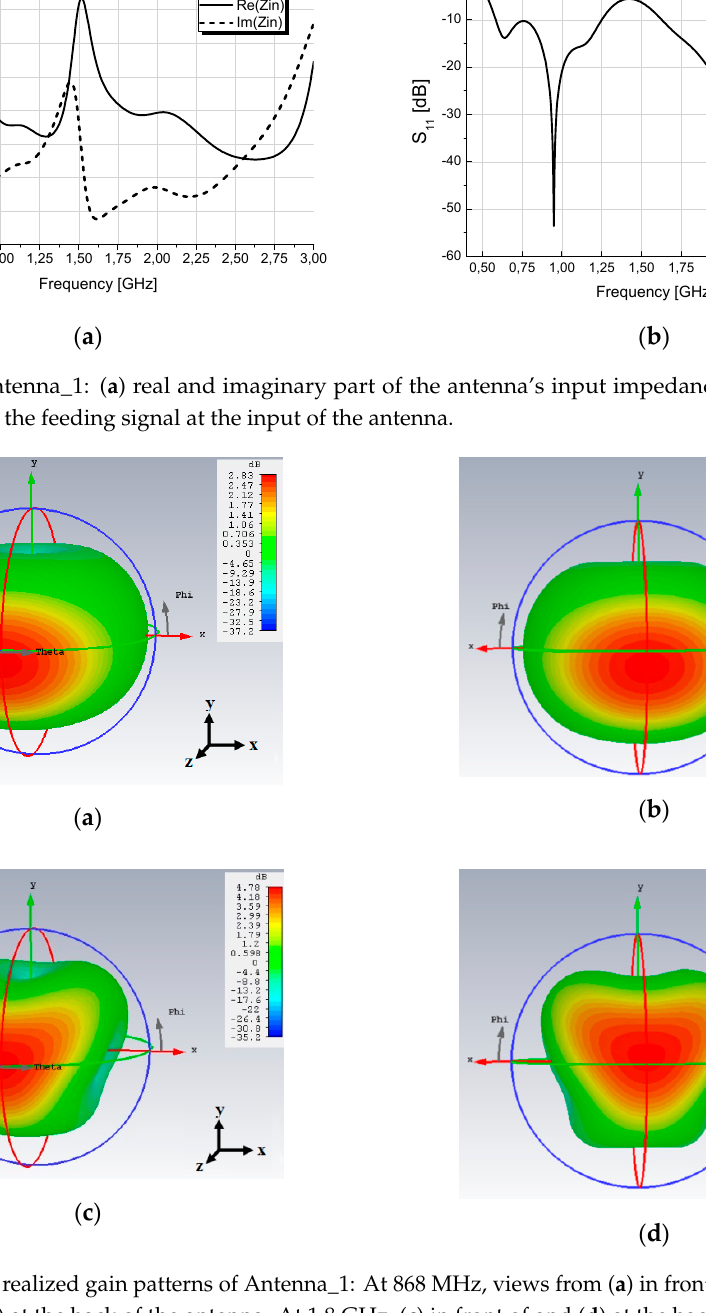
Figure 4. 3D realized gain patterns of Antenna_1: At 868 MHz, views from ( a ) in front of the antenna’s plane and ( b ) at the back of the antenna. At 1.8 GHz, ( c ) in front of and ( d ) at the back of the antenna.